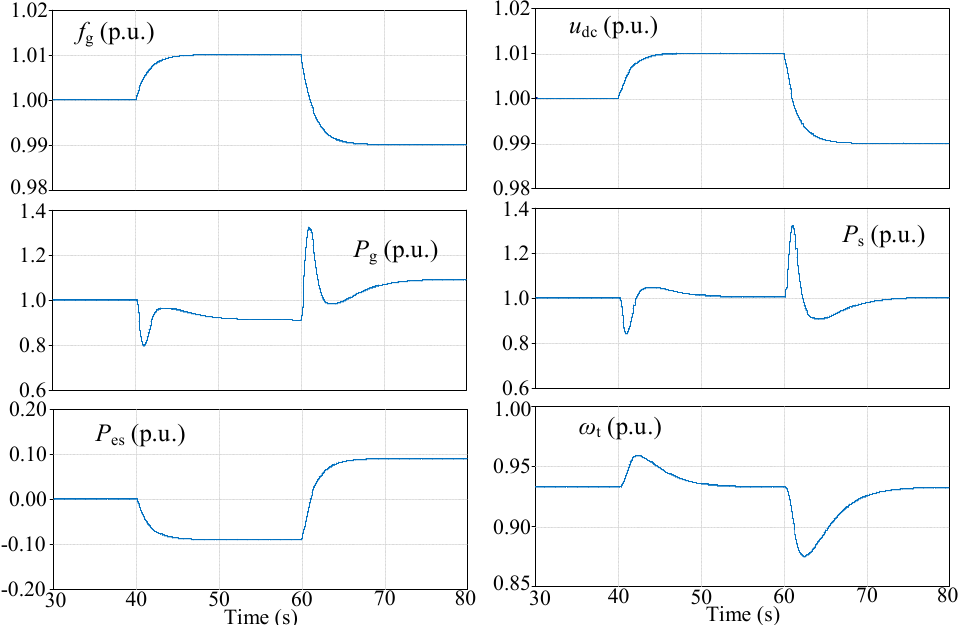
Figure 8. Simulation results of inertial response and primary frequency regulation when the grid frequency fluctuates.